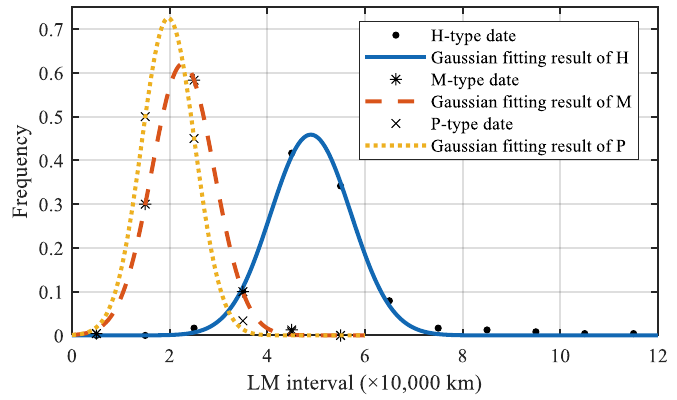
Figure 3. The LM histogram of the three types of PCCS.